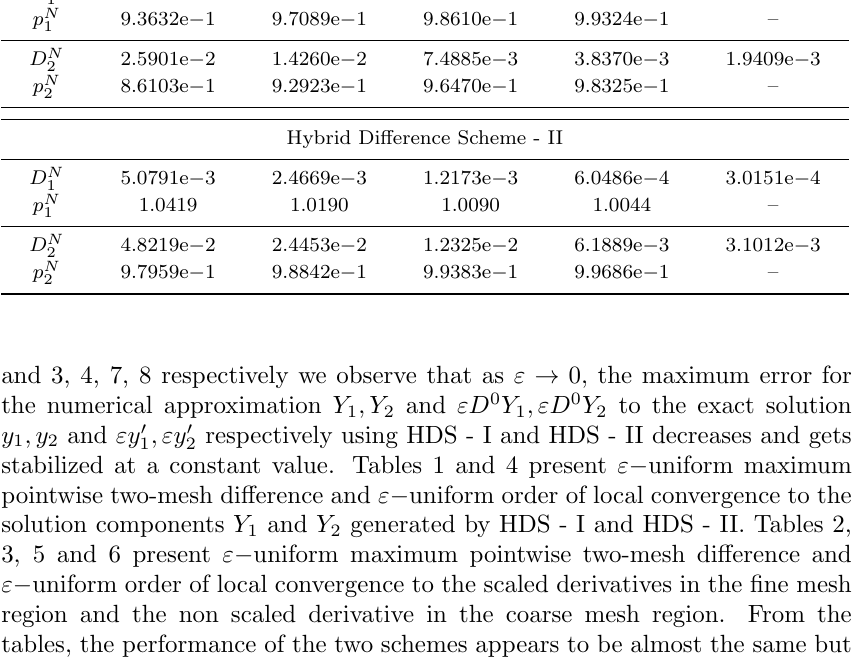
Table 6. Values of D N